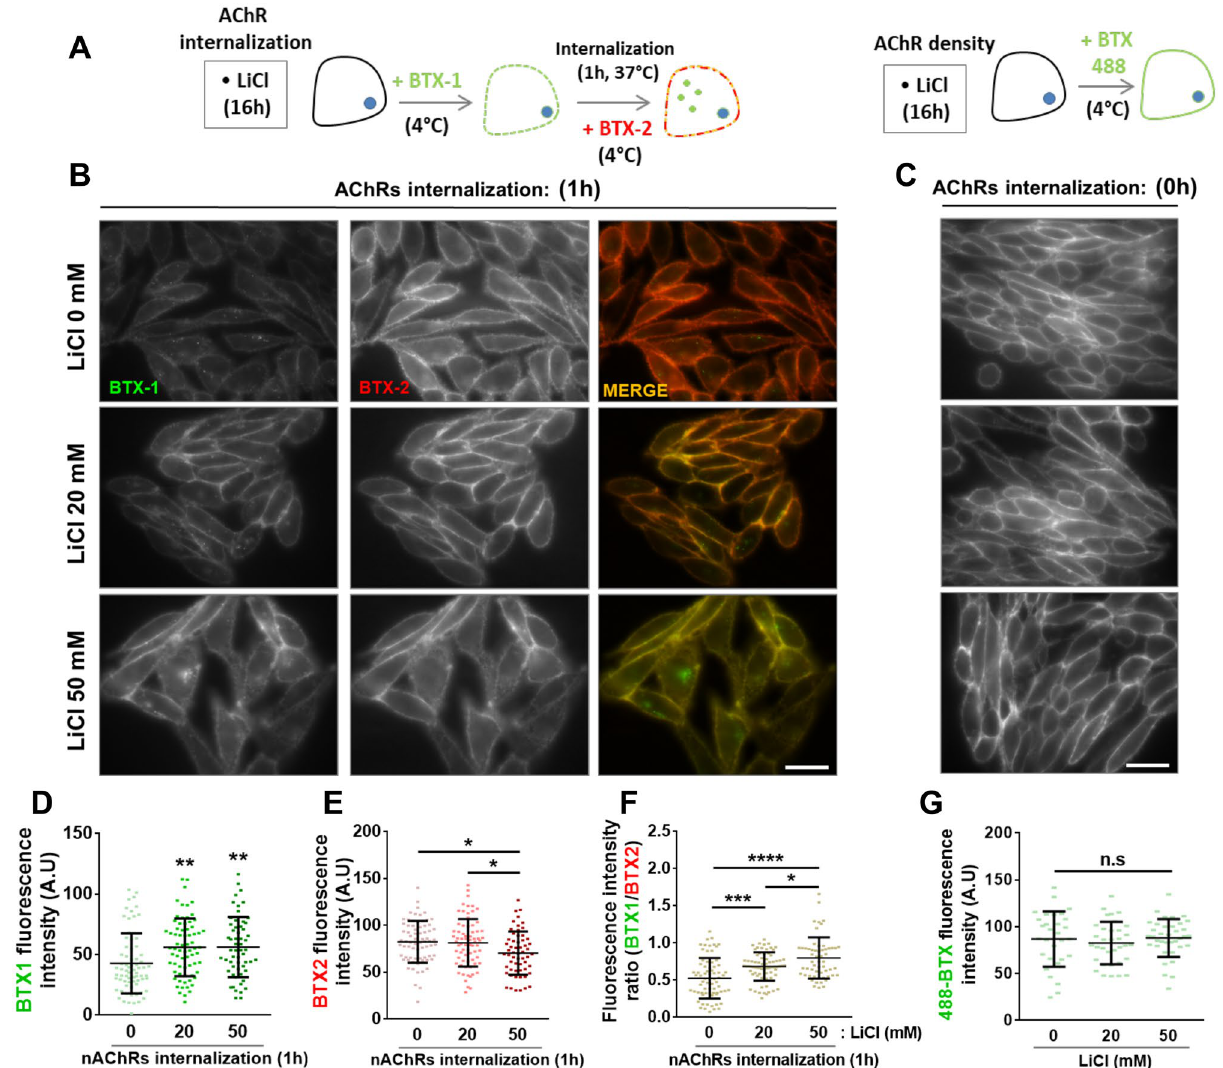
Figure 4. Lithium negatively regulates nAChR turnover in CHO-K1/A5 cells. ( A ) Experimental design used to analyse the effect of lithium on nAChR internalization in CHO-K1/A5. Briefly, cells were incubated overnight with PBS or LiCl at 20 and 50 mM. Then, AlexaFluor555-BTX (BTX1, pseudo-coloured green) was used to label surface nAChRs at 4 °C. After receptors were allowed to internalize for 1 h at 37 °C, AlexaFluor488-BTX (BTX2, pseudo-coloured red) was used to label new nAChRs at the cell surface. To evaluate the effect of lithium on nAChRs density, control- or lithium-treated cells were incubated with AlexaFluor488-BTX for 45 min at 4 °C and then fixed for subsequent fluorescence microscopy visualization. ( B ) Fluorescence microscopy imaging of CHO-K1/A5 cells labelled with BTX1 and BTX2 revealed the degree of nAChR turnover at the cell surface after 1 h of internalization. ( C ) Fluorescence microscopy imaging of CHO-K1/A5 cells labelled only with AlexaFluor488-BTX after treatment with LiCl or PBS was performed to determine nAChRs density at the cell surface. Bar = 50 µm. Mean fluorescence intensity for ( D ) BTX1 or ( E ) BTX2 at the cell surface after 1 h of nAChR internalization was quantified. Also, ( F ) BTX1/BTX2 fluorescence intensity ratio at the cell surface was measured and represented in respective graphs as means ± SD along with individual values of two independent experiments. For each group, the membrane-associated fluorescence intensity of 60–80 CHO-K1/A5 cells was analysed. One-way ANOVA and Tukey’s multiple comparisons test were performed for each condition. **** p < 0.0001; *** p < 0.001; ** p < 0.01; * p <